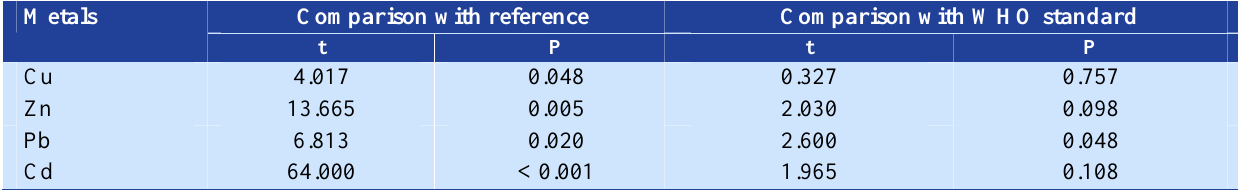
Table 6. Independent t-test and one sample t-test results for the comparison of the heavy metals in the medical plants of the contaminated site with those of the reference site and world health organization (WHO) standards for edible plants, respectively